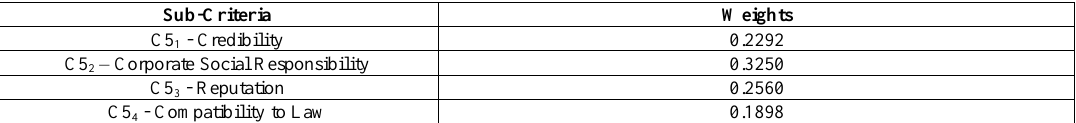
Table 7. Weights of sub-criteria within trustworthiness cluster.